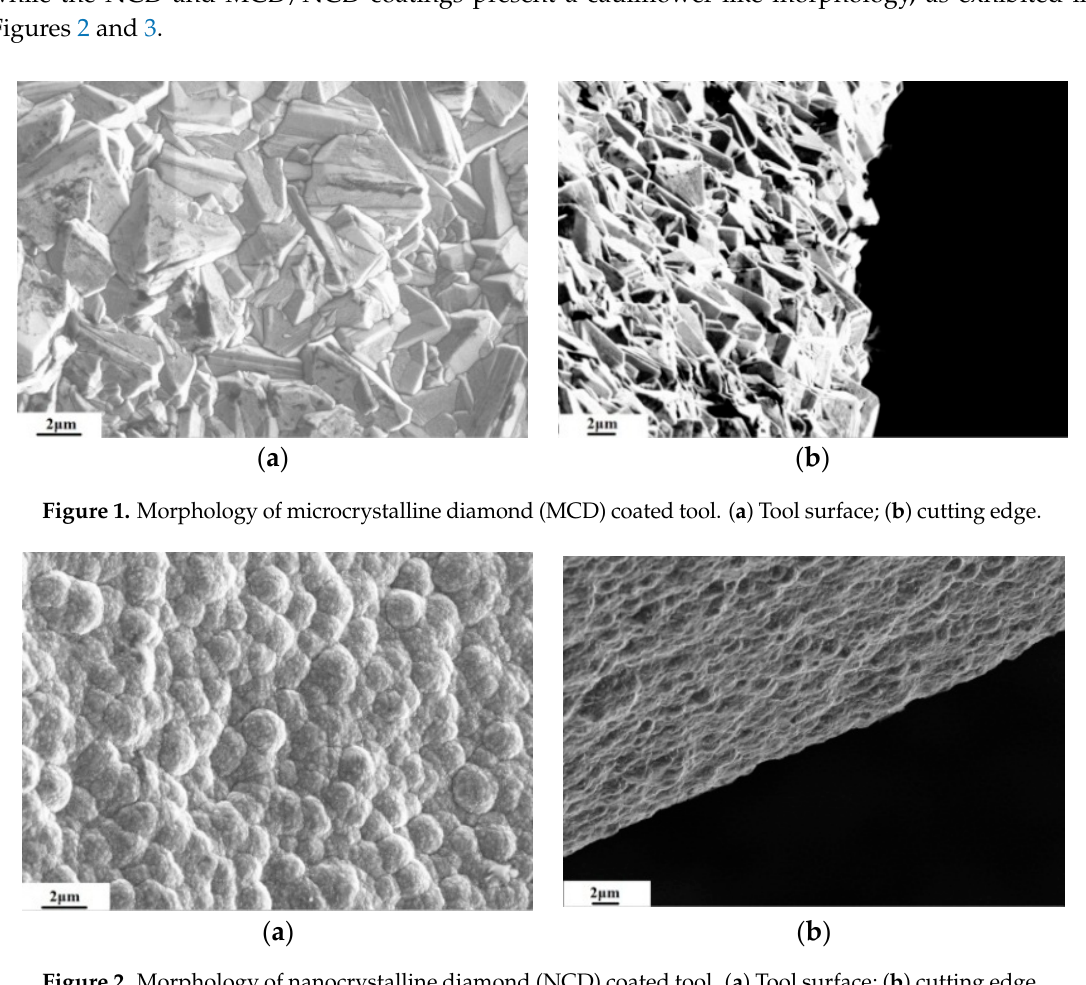
Figure 3. Morphology of MCD/NCD coated tool. ( a ) Tool surface; ( b ) cutting edge.